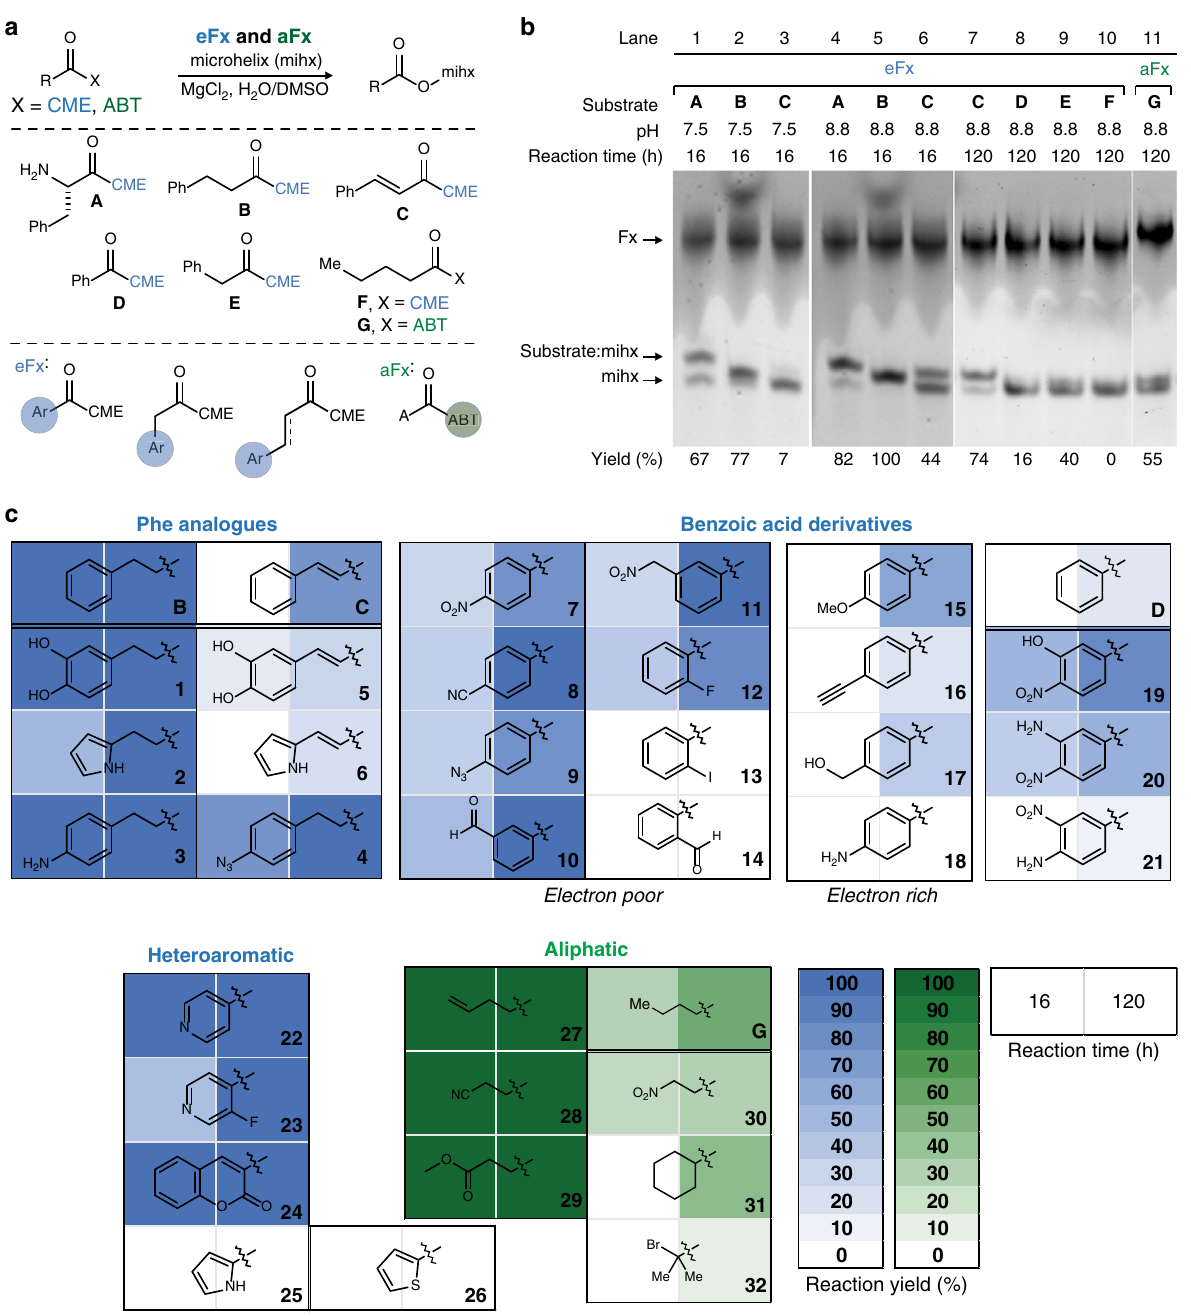
Fig. 2 Expanding the Fx substrate scope to analogs with various scaffolds. a Systematic design of noncanonical substrates for ribosome mediated polymerization. Phe ( A ) and structurally diversi fi ed noncanonical substrates ( B – G ). b Fx-catalyzed acylation under optimized conditions. Acid (pH 5.2) denaturing PAGE analysis under various conditions for Fx-catalyzed acylations of a microhelix tRNA (22 nt) with A – G . The acylation reactions were performed using eFx (45 nt) or aFx (47 nt) and monitored over 120 h at two different pHs (7.5 vs. 8.8). Reaction condition: 50 mM HEPES (pH 7.5) or bicine (pH 8.8), 60 mM MgCl 2 , 1 µ M microhelix, 5 µ M Fx, and 5 mM substrates in 20 % (v/v) DMSO solution. c The range of noncanonical substrates compatible with Fx was further extended on four different monomer structure (Phe analogs, benzoic acid derivatives, heteroaromatic, and aliphatic substrates). All acylation heat maps are shaded by percent conversion of microhelix. The blue and green color codes are used for the reaction with